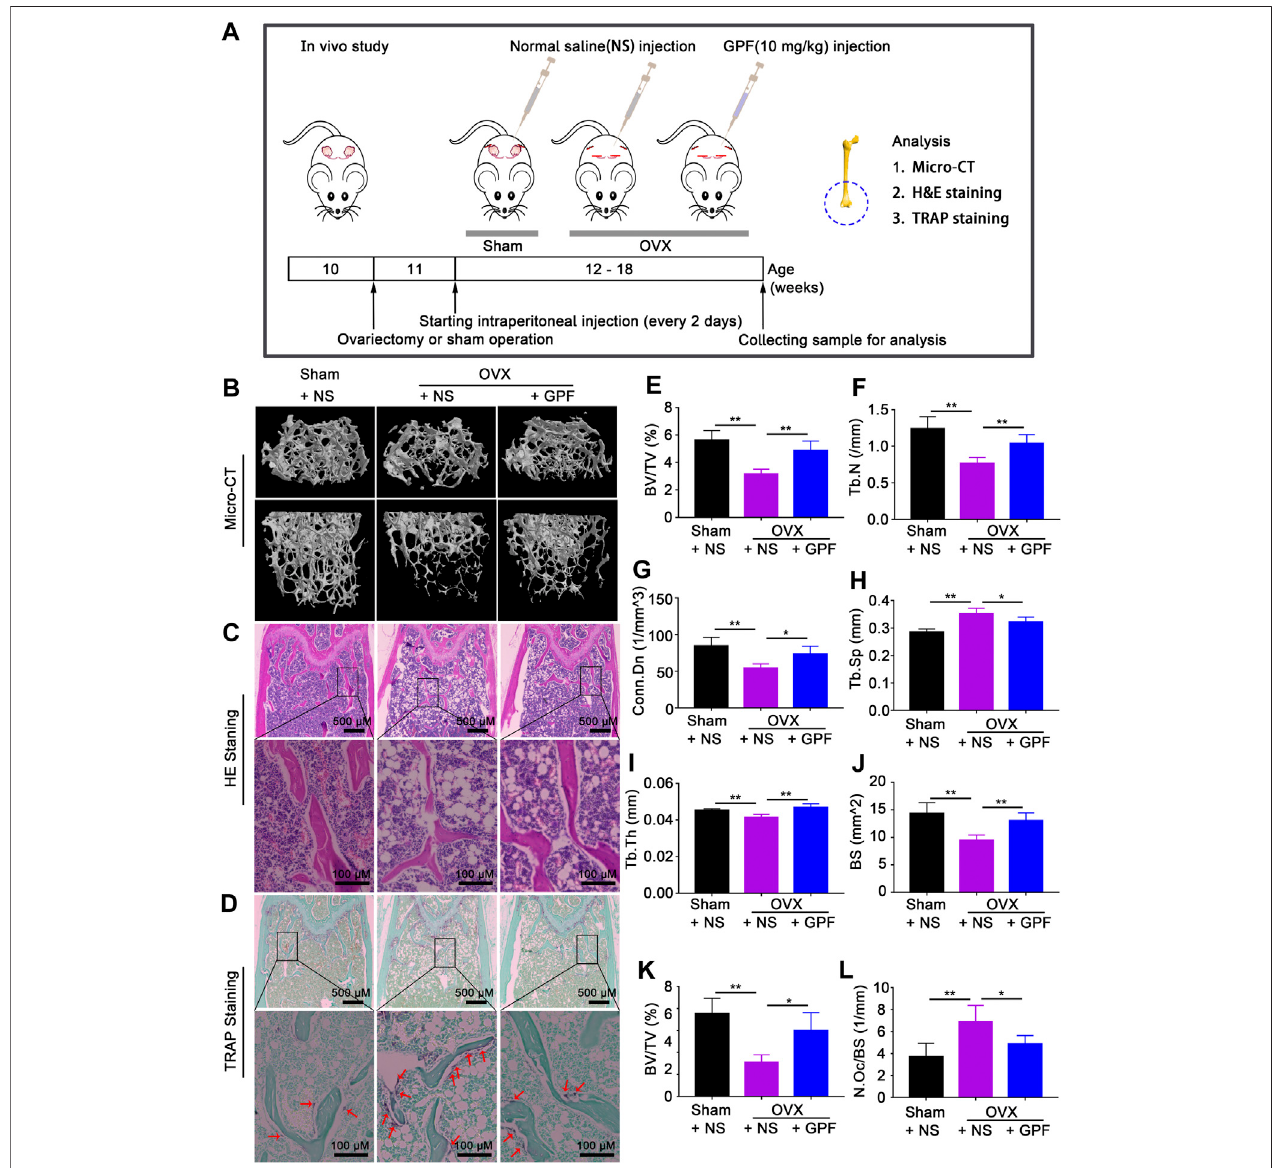
FIGURE 5 | GPF relieves ovariectomy-induced osteoporosis in vivo . (A) Protocol of the in vivo experiment and sensitive techniques for evaluating therapeutic ef fi cacy of GPF. (B) Representative micro-CT images of femurs exerting that GPF treatment prevents OVX-induced bone loss. (C,D) Representative images of H&E, TRAP staining of decalci fi ed bone sections. (E – J) Quantitative analyses of parameters regarding bone microstructure, including BV/TV, Tb.N, Conn. Dn, Tb. Sp, Tb.Th, and BS ( n (cid:2) 6). (K,L) Quantitative analyses of all bone sections, including BV/TV and N. Oc/BS ( n (cid:2) 6). All bar graphs are presented as mean ± SD. * p < 0.05 and ** p < 0.01 between the indicated groups. One-way